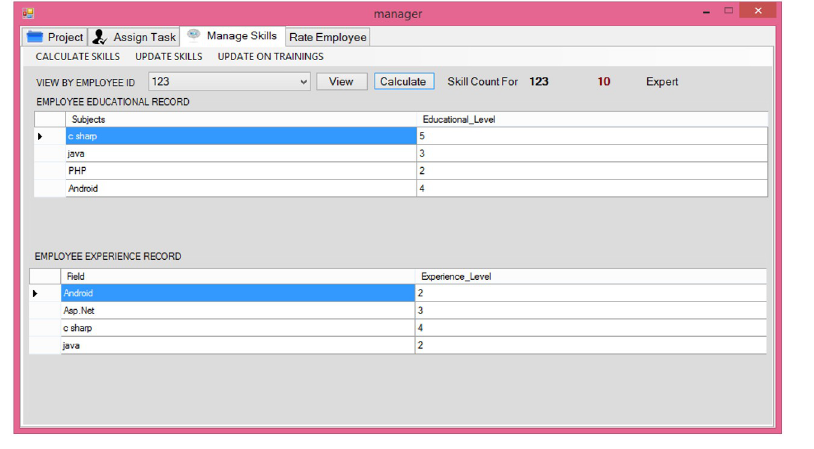
Fig 5. Employee skill